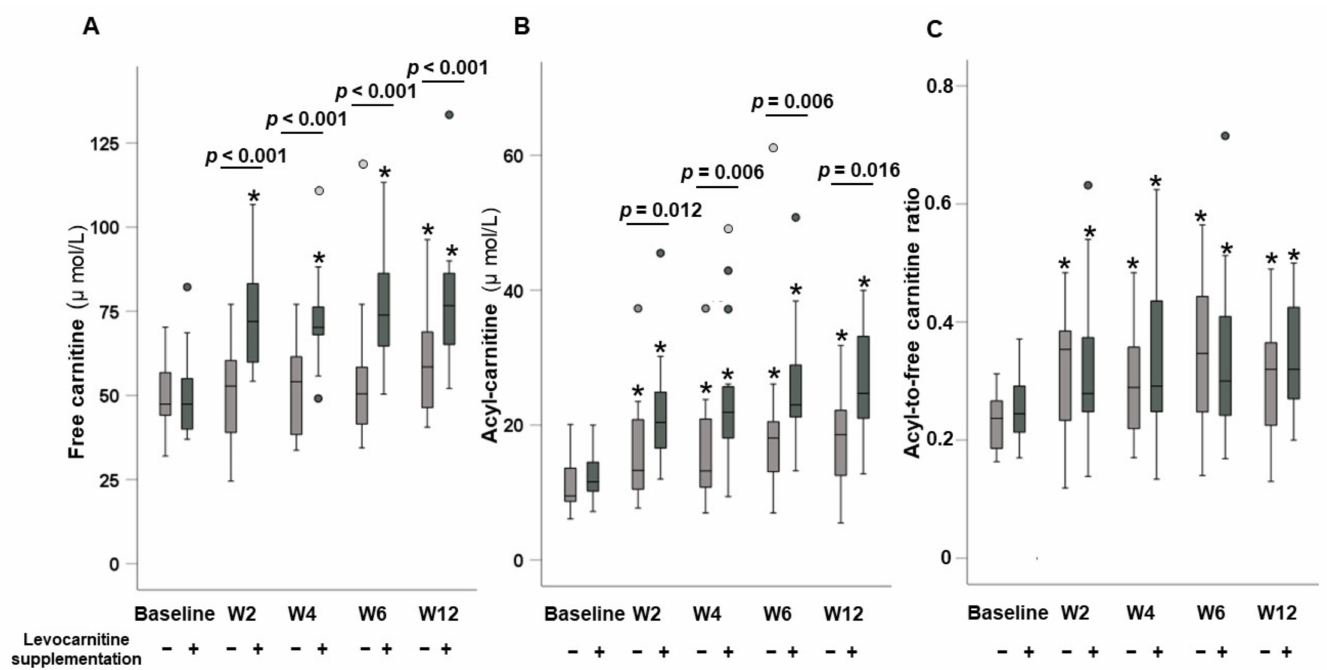
Figure 3. Time course of ( A ) serum free carnitine levels, ( B ) serum acyl-carnitine, and ( C ) the acyl-to-free carnitine ratio between patients without and with levocarnitine supplementation after lenvatinib therapy. * p < 0.05 vs. baseline.